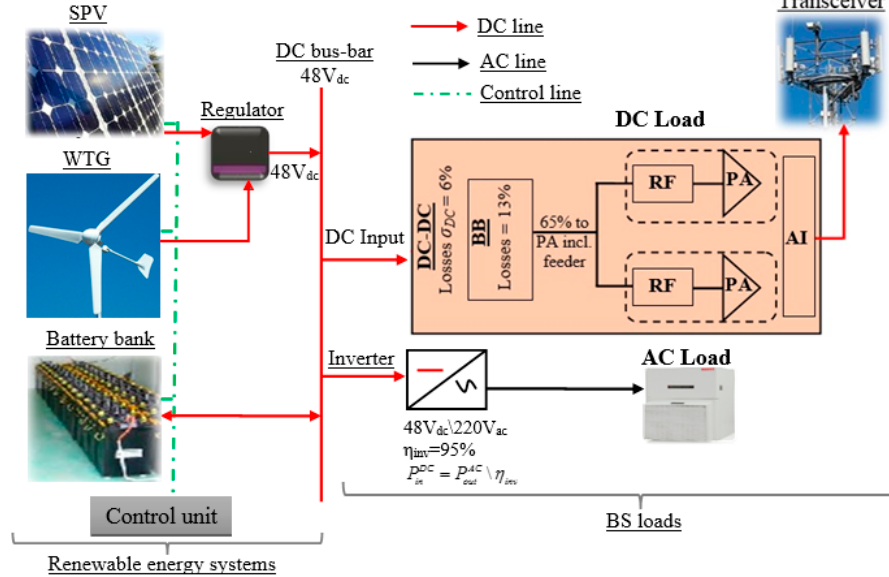
Figure 2. System model of the hybrid SPV/WTG power scheme for an LTE-macro BS.